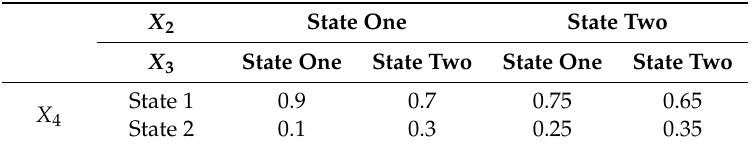
Table 1. Sample of the Conditional Probabilities Tables (CPT) of X 4 in Figure 1. X